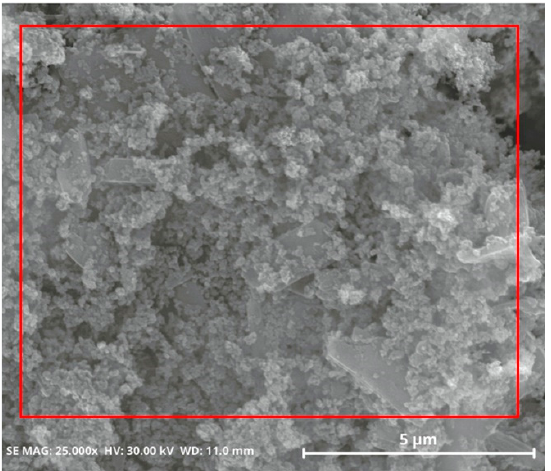
Figure 9. SEM images of purified silica powder, which was removed with DI water at 60 °C for 3 h.